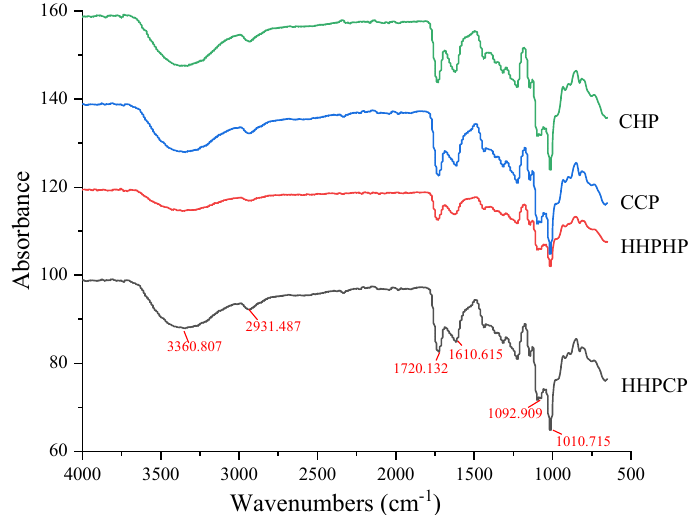
Figure 3. FTIR spectra of Satsuma mandarin peel pectin extracted by different extraction methods.